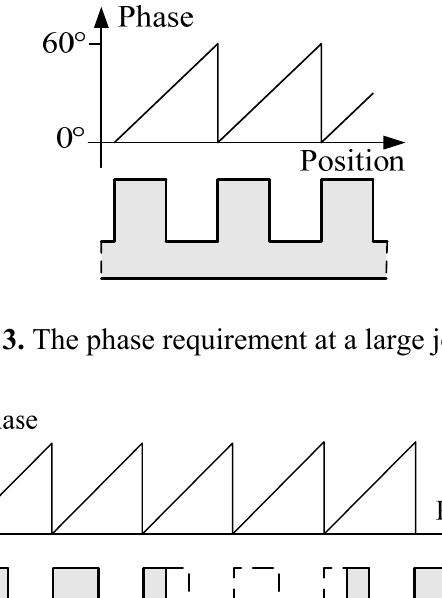
Figure 2. The relationship between the electrical phase angle and the tooth-slot structure.